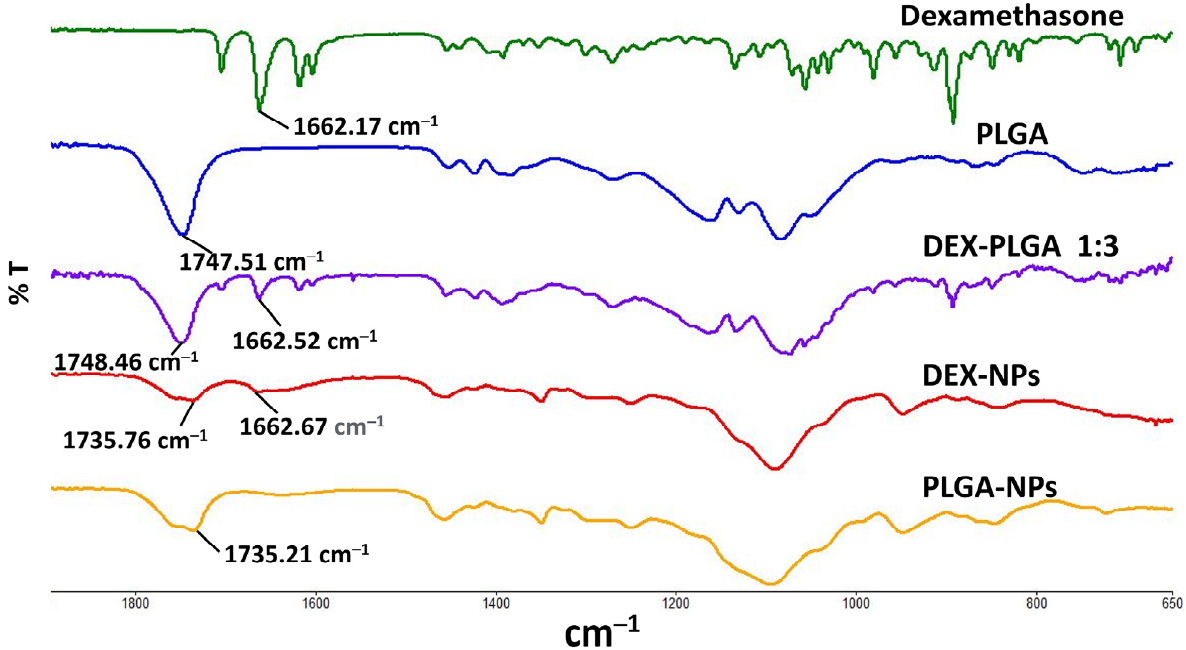
Figure 2. FTIR spectra of DEX, PLGA, physical mixture, DEX-NPs, and blank